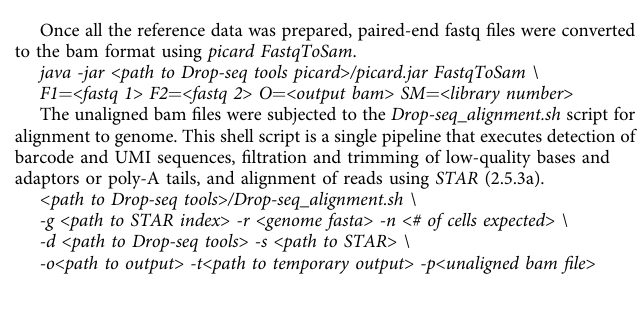
Fig. 8 Transcriptome-wide comparisons between embryonic and larval lymph gland hemocytes in Drosophila . a Two-dimensional projections of hemocytes in the lymph gland (top) and circulation (bottom) at 96 and 120 h AEL. b Combined projection (top) and proportions of major cell types (bottom) in the lymph gland (yellow) and in circulation (cyan). Inset (top) shows the ratio of major cell types between the lymph gland (L) and in circulation (C). c Dot plot of marker genes highly enriched in a lineage-speci fi c or cell type-speci fi c manner. The colors show the origin of the datasets (yellow, lymph gland; cyan, circulation). Signi fi cant marker genes with FDR-adjusted P < 0.001 were 1 μ l. Around 10min Drop-seq run was performed for each experiment. After cDNA synthesis, scRNA-seq was performed using Illumina NextSeq.